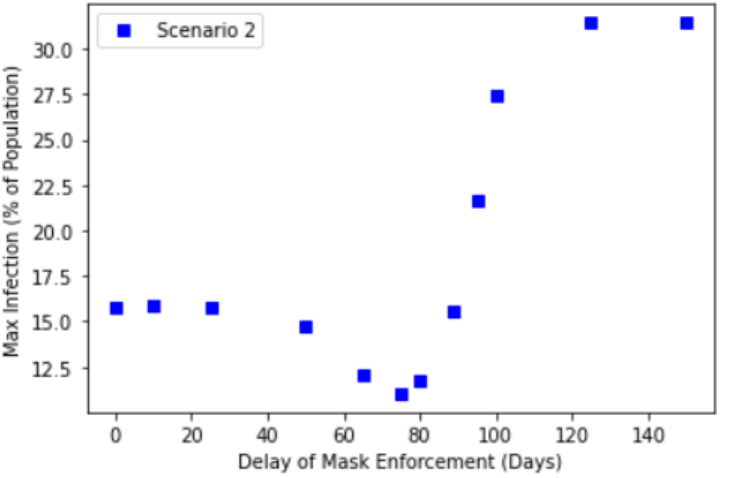
Figure 5. Maximum infection against delay in mask enforcement for Scenario 2: SEIR with grad- ual